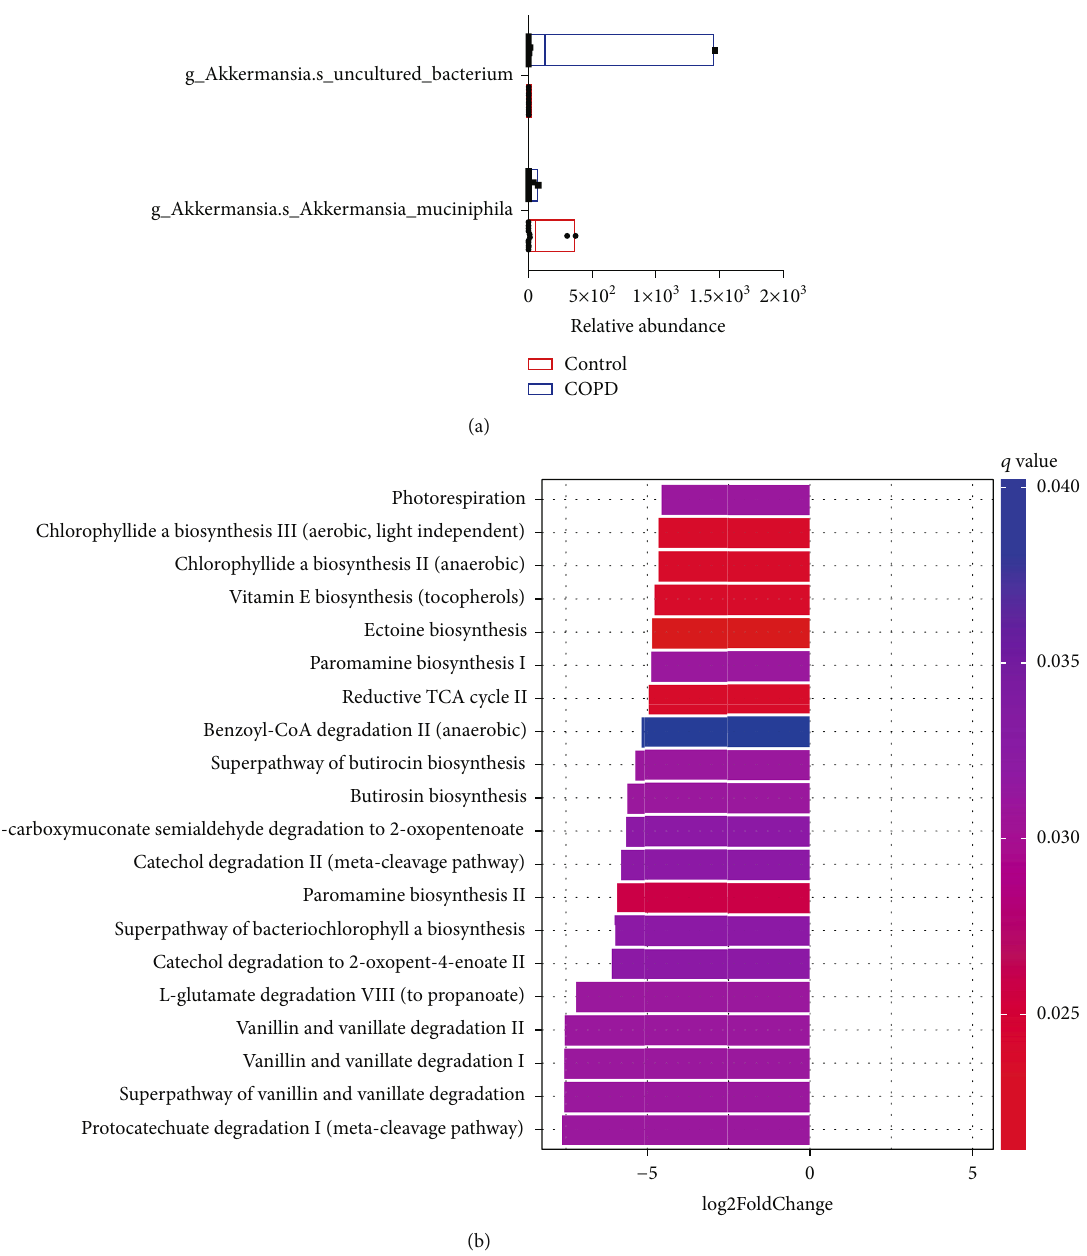
Figure 4: Species abundance of Akkermansia and functional annotation of gut microbiota at MetcyC. (a) The species abundance of the genus Akkermansia at the species level. (b) Metcyc annotated the functional changes of gut